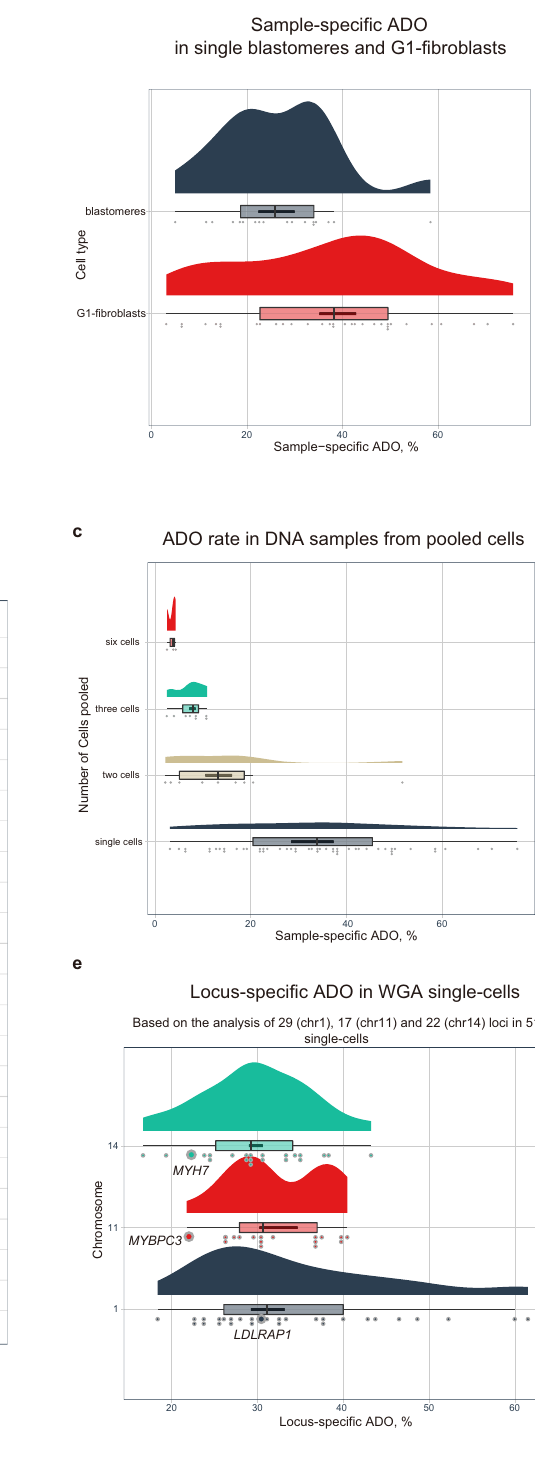
Fig. 2 | Allelic dropouts due to whole-genome ampli fi cation biases limit the genotyping accuracy in human preimplantation embryos. a Chromosomal distributionof608knownheterozygouslociinfemale fi broblastdonorusedinthe custom Ampliseq panel for investigation of ADO rates in single fi broblasts and blastomeres from SCNT embryos. b Distribution of sample-speci fi c ADO rates observed in individual fi broblasts synchronized at G0 – G1 phase of the cell cycle ( n =31) and blastomeres of cycling cleavage stage SCNT embryos ( n =18); n represents biologically independent number of samples collected over four inde- pendent experiments. c Distribution of ADO rates in WGA single-cell DNA ( n =51) andWGADNAsamplespooledfromtwocells( n =9),threecells( n =8)andsixcells